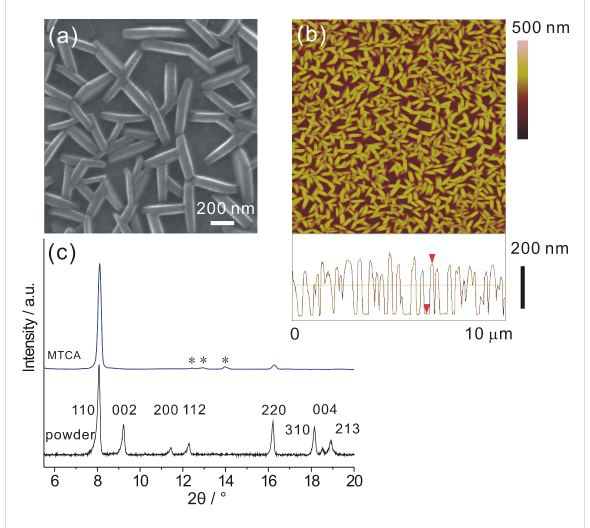
Figure 4: Characterization of [Zn 2 (adc) 2 (dabco)] grown on a MTCA surface at 15 °C after 45 cycles by using the layer-by-layer deposition method. (a) High-magnification SEM image; (b) AFM image and cross- sectional profile; (c) XRD patterns of SURMOF and powder sample. The asterisks denote signals from the